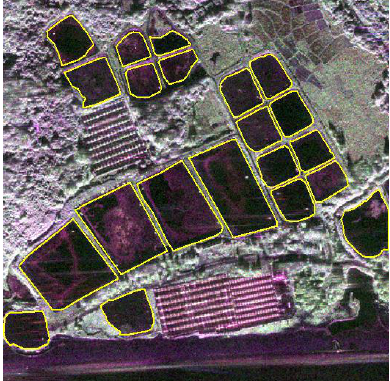
Figure 9. The extraction result of coastal farms of Hailing